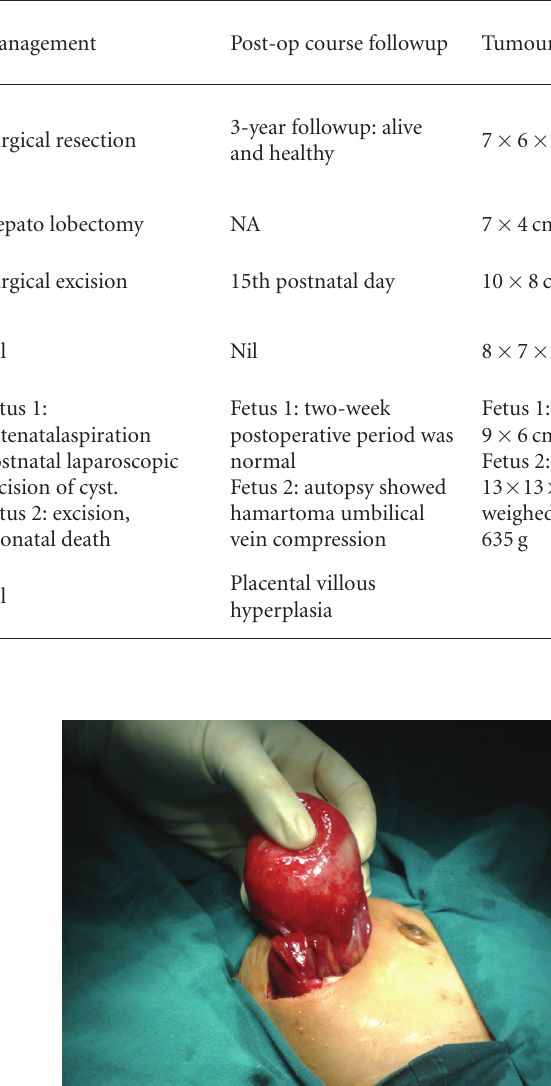
Table 1: Congenital mesenchymal hamartoma of liver: presentation and management.